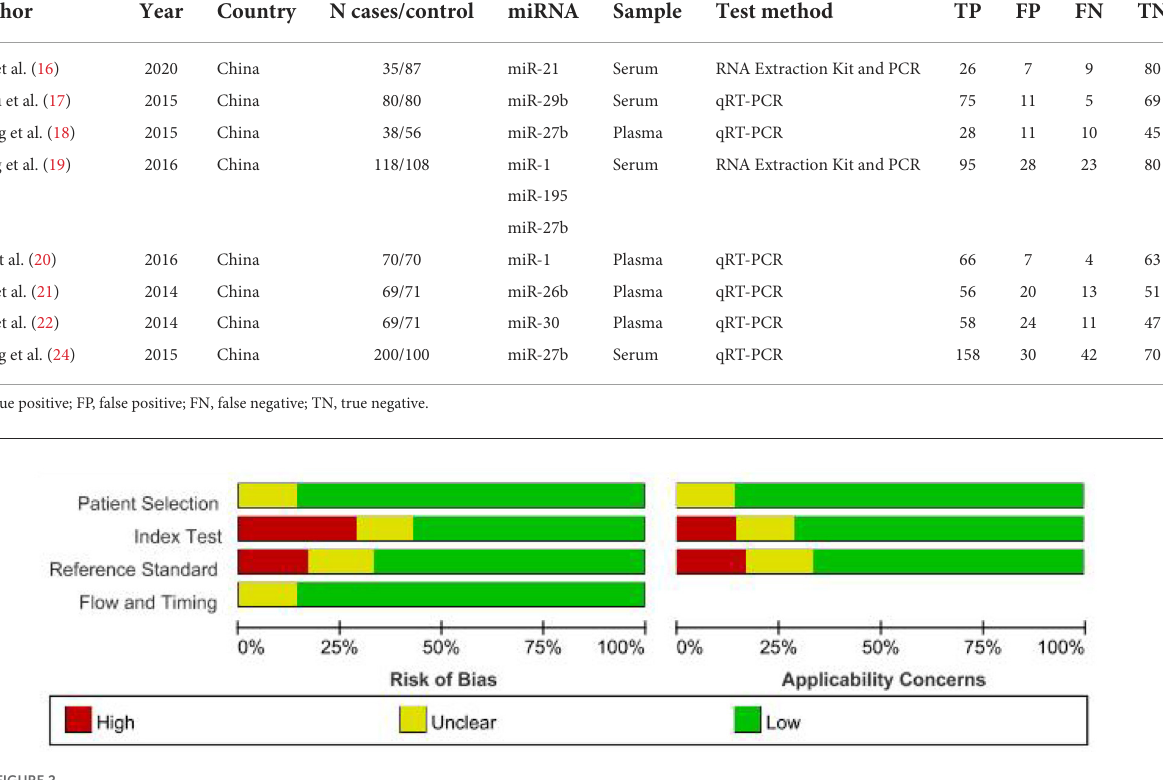
FIGURE2 Bar chart of QUADAS-2 risk of bias